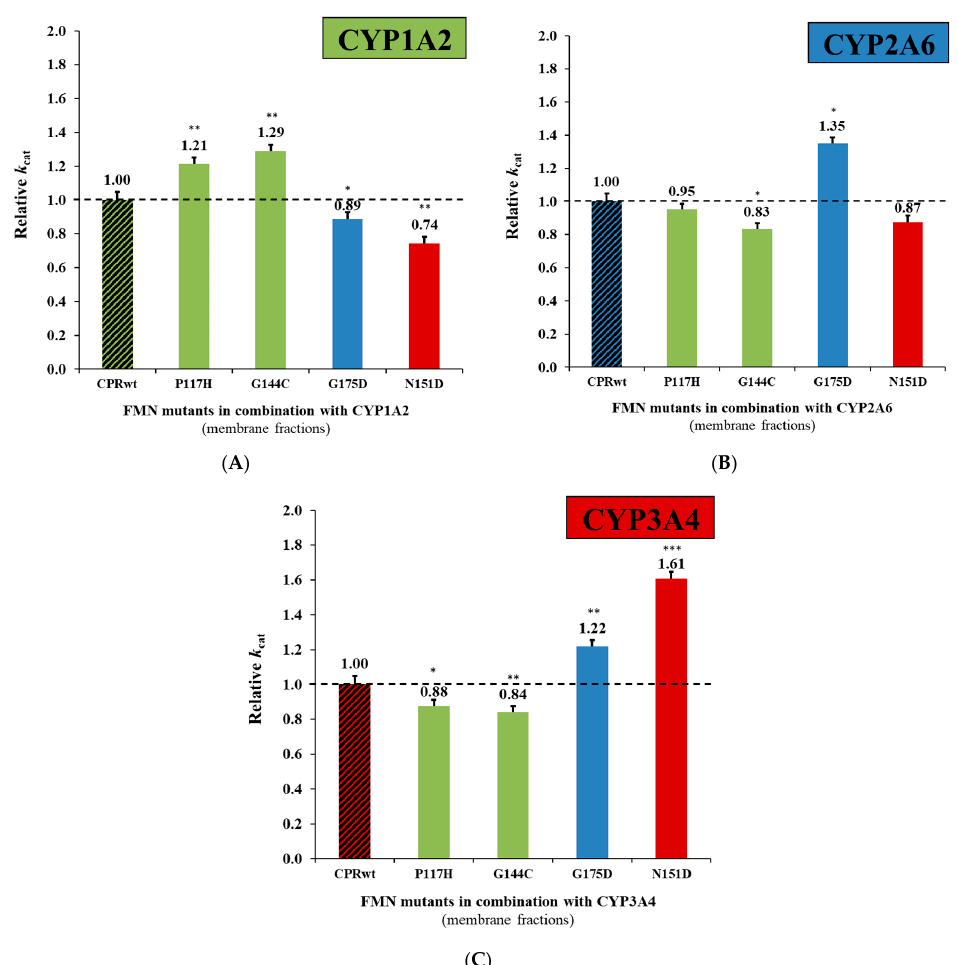
Figure 1. Relative turnover rates ( k cat ) (x fold) of the CPR mut :CYP1A2 EROD ( A ), CPR mut :CYP2A6 C7H ( B ), and CPR mut :CYP3A4 DBODF ( C ) activities, normalized by the k cat demonstrated by CPR wt /CYP (determined in membrane fractions; technical replicates N = 3). CPR ‐ FMN ‐ domain wildtype (CPR wt :CYP, black stripes). CPR ‐ FMN ‐ domain mutants previously demonstrated to support a gain in CYP1A2 ‐ mediated EROD ‐ (P117H and G144C: green), CYP2A6 ‐ mediated C7H ‐ (G175D: blue), and CYP3A4 ‐ mediated DBODF ‐ activity (N151D: red). k cat values of the CPR mut /CYP were compared with the ones of the CPR wt /CYP applying the unpaired t test (*** p < 0.0005; ** p < 0.005; * p < 0.05).